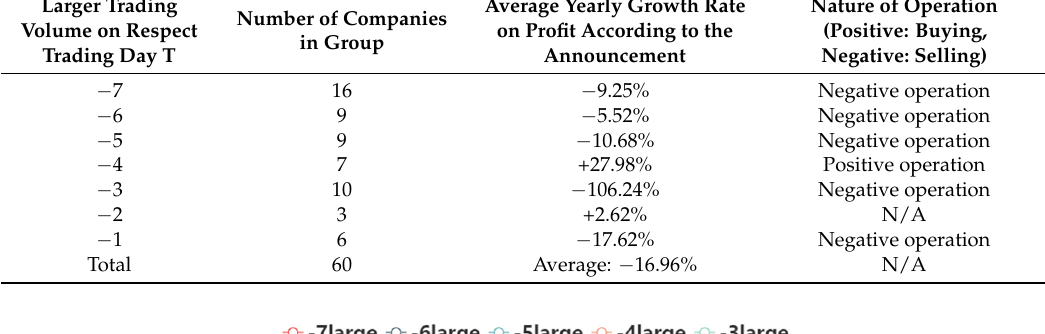
Table 7. Comparison of Larger Trading Volume Classified Groups in typical days during Comparison of Larger Trading Volume Classified Groups in typical days during pre-announcement periods. pre-announcement periods.